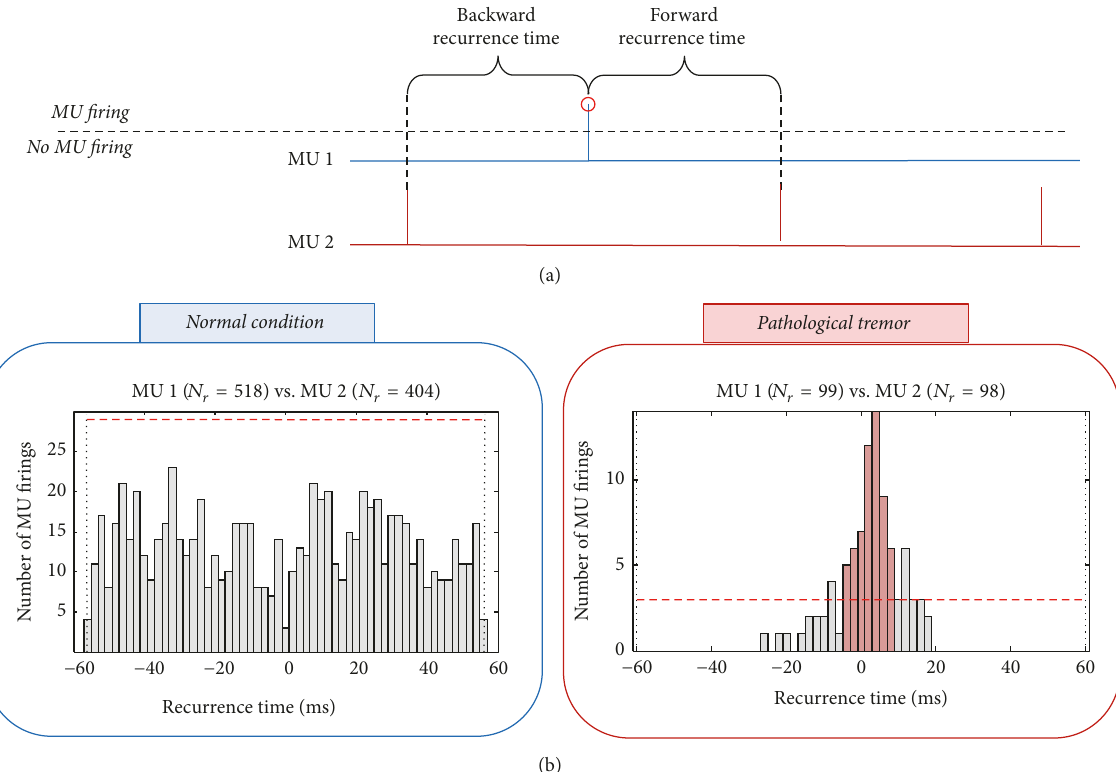
Figure 5: Definition of backward and forward motor unit (MU) recurrence times (a) and representative histograms of recurrence times in a healthy young control ((b), left panel) and a patient with pathological tremor ((b), right panel). The 99% confidence limit is depicted by red dashed line. For the peaks exceeding the 99% confidence limit, the peak area (red filling in (b), right panel) was calculated. 𝑁 𝑟 denotes the number of motor unit